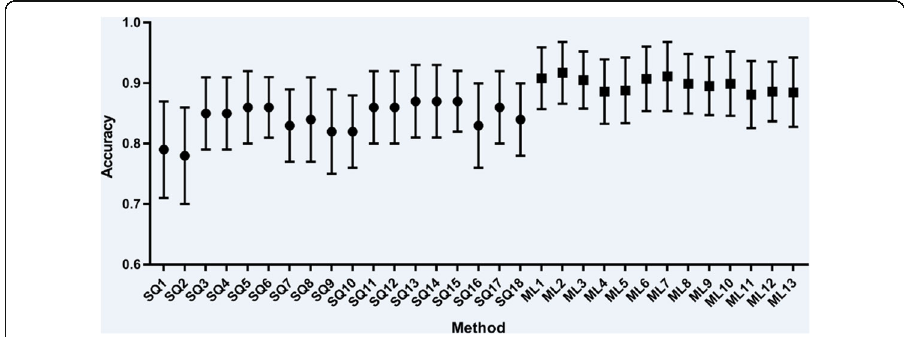
Fig. 3 Accuracy results for all semi-quantification and machine learning methods applied to local data. Semi-quantification results are grouped to the left of the graph and machine learning algorithms to the right. Whiskers represent one standard